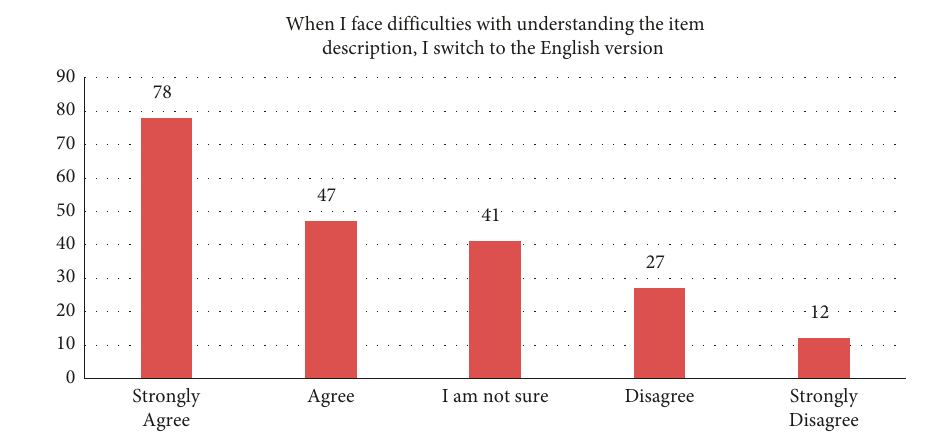
Figure 8: Participants’ responses regarding the tendency to switch to the English version in case of any difficulties in understanding the items’